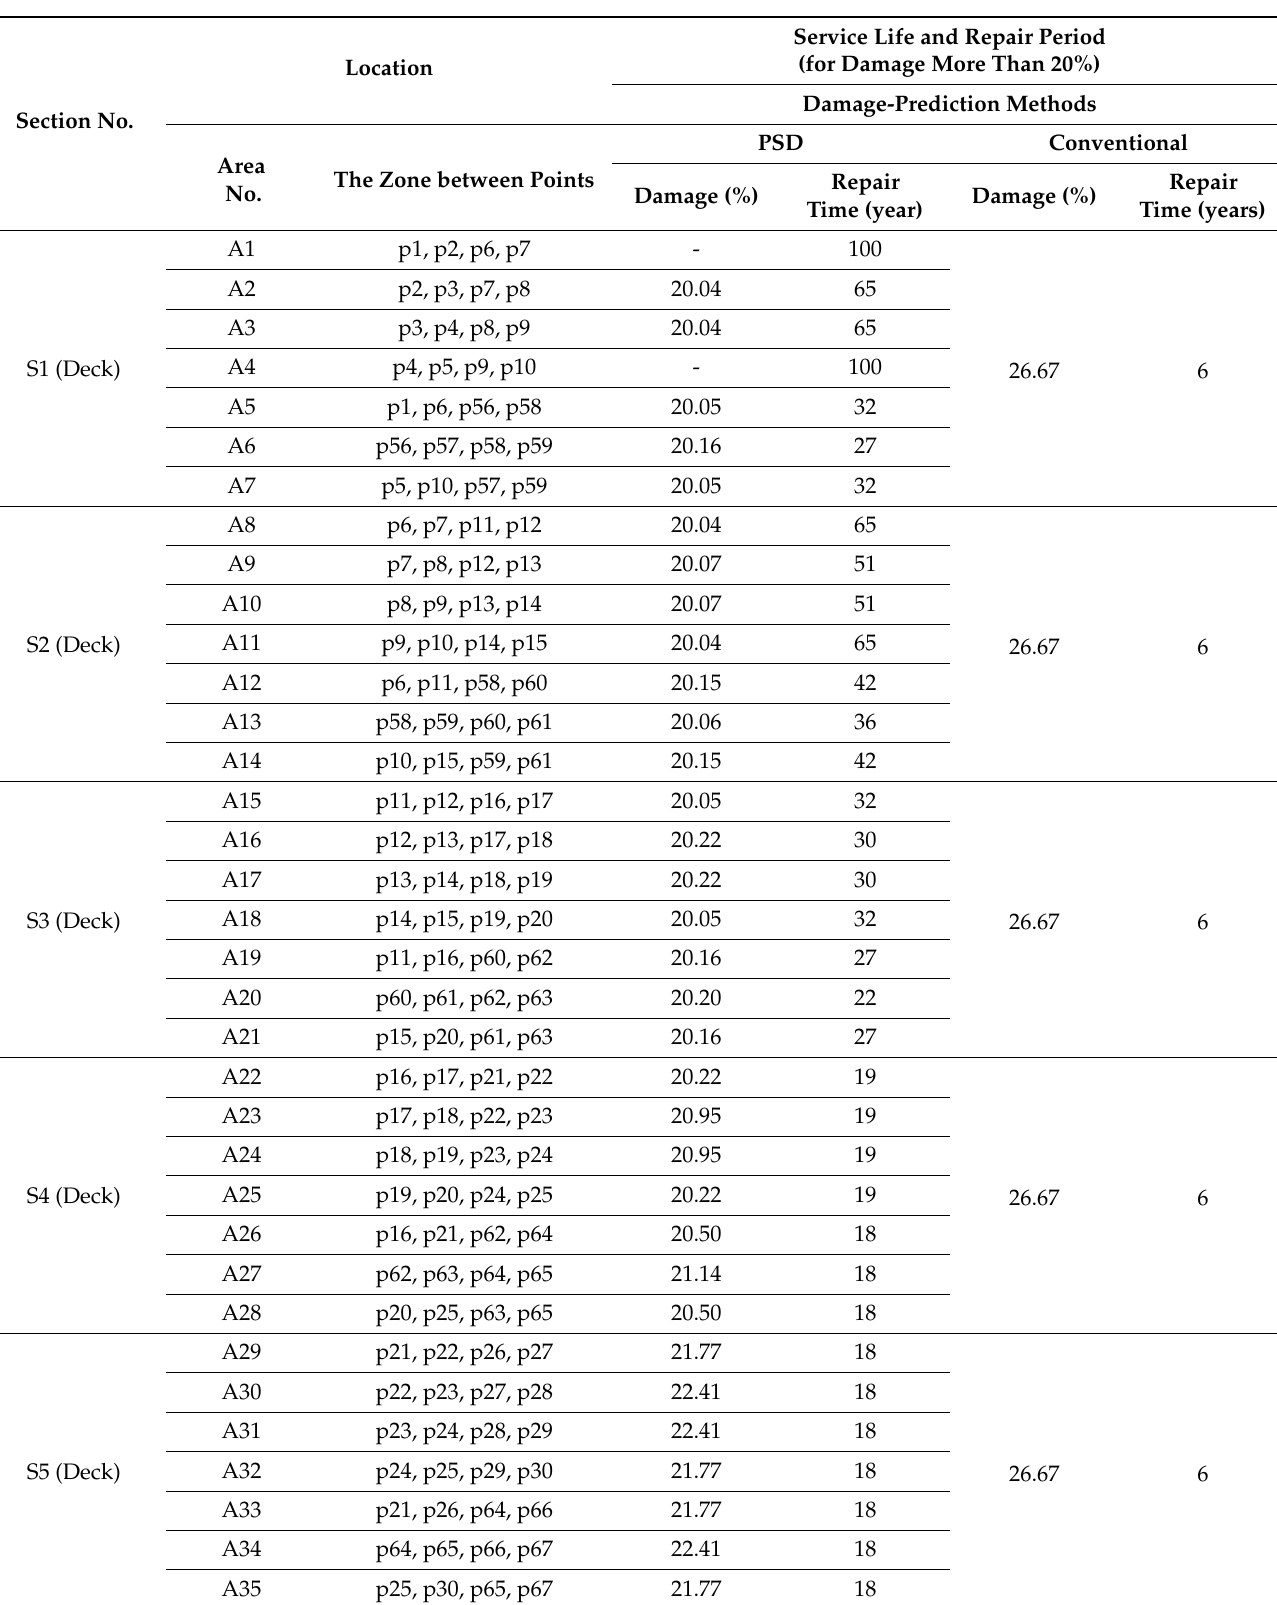
Table 4. Identified location, time, and amount of damage, and conventional service life of the Arosa